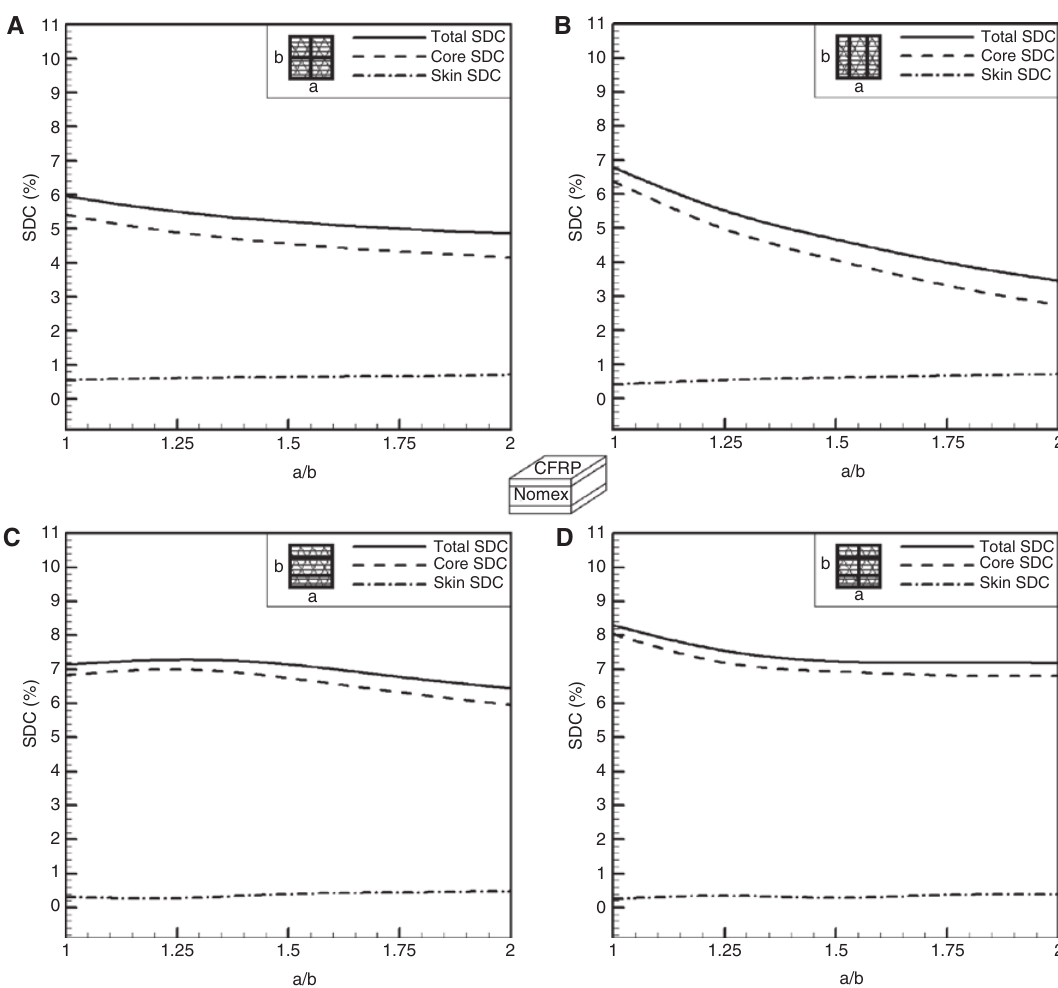
Figure 3: Damping of an all-free, [− 60, 0, 60] CFRP/Nomex honeycomb sandwich panel versus aspect ratio, in various modes. (A) First mode, (B) second mode, (C) third mode, (D) fourth